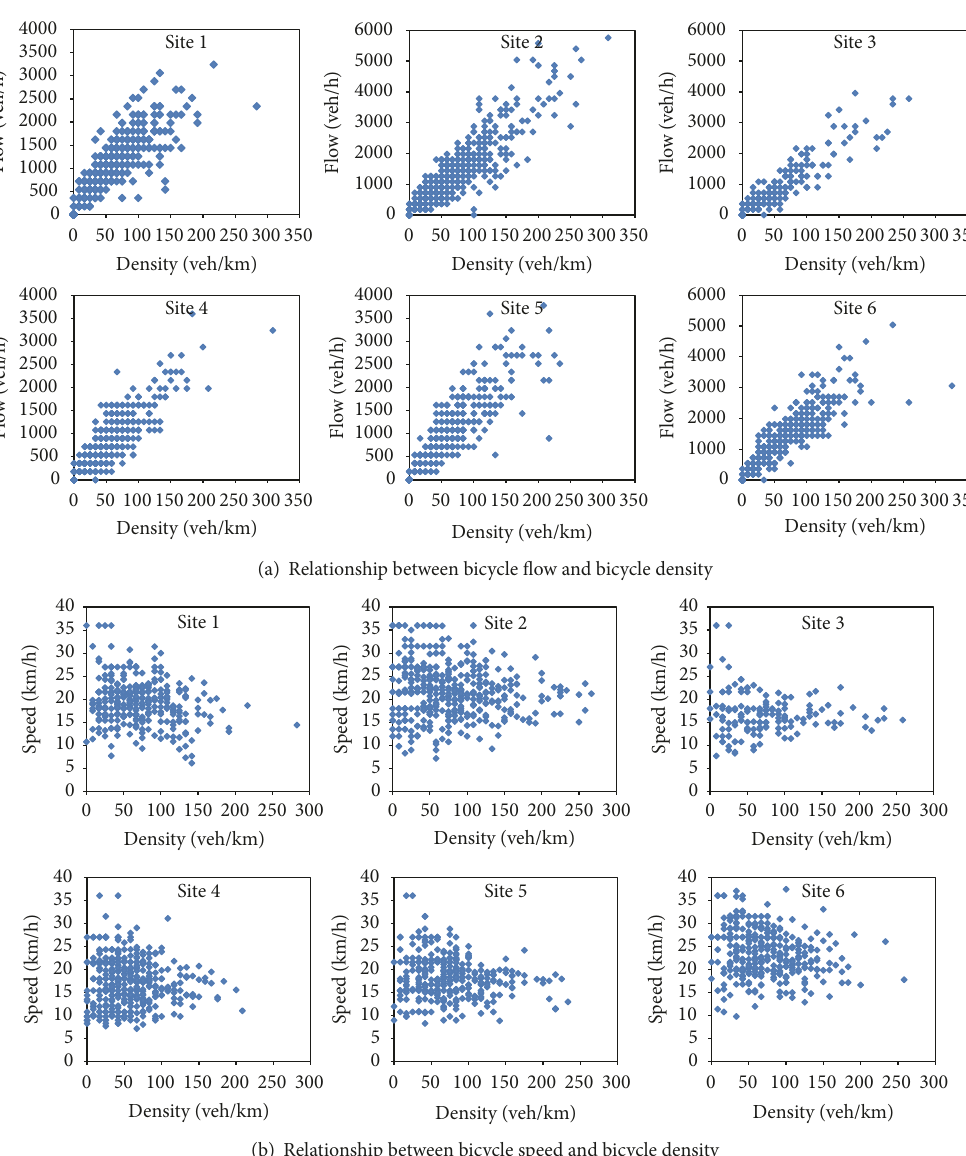
Figure 4: Relationship between bicycle traffic flow